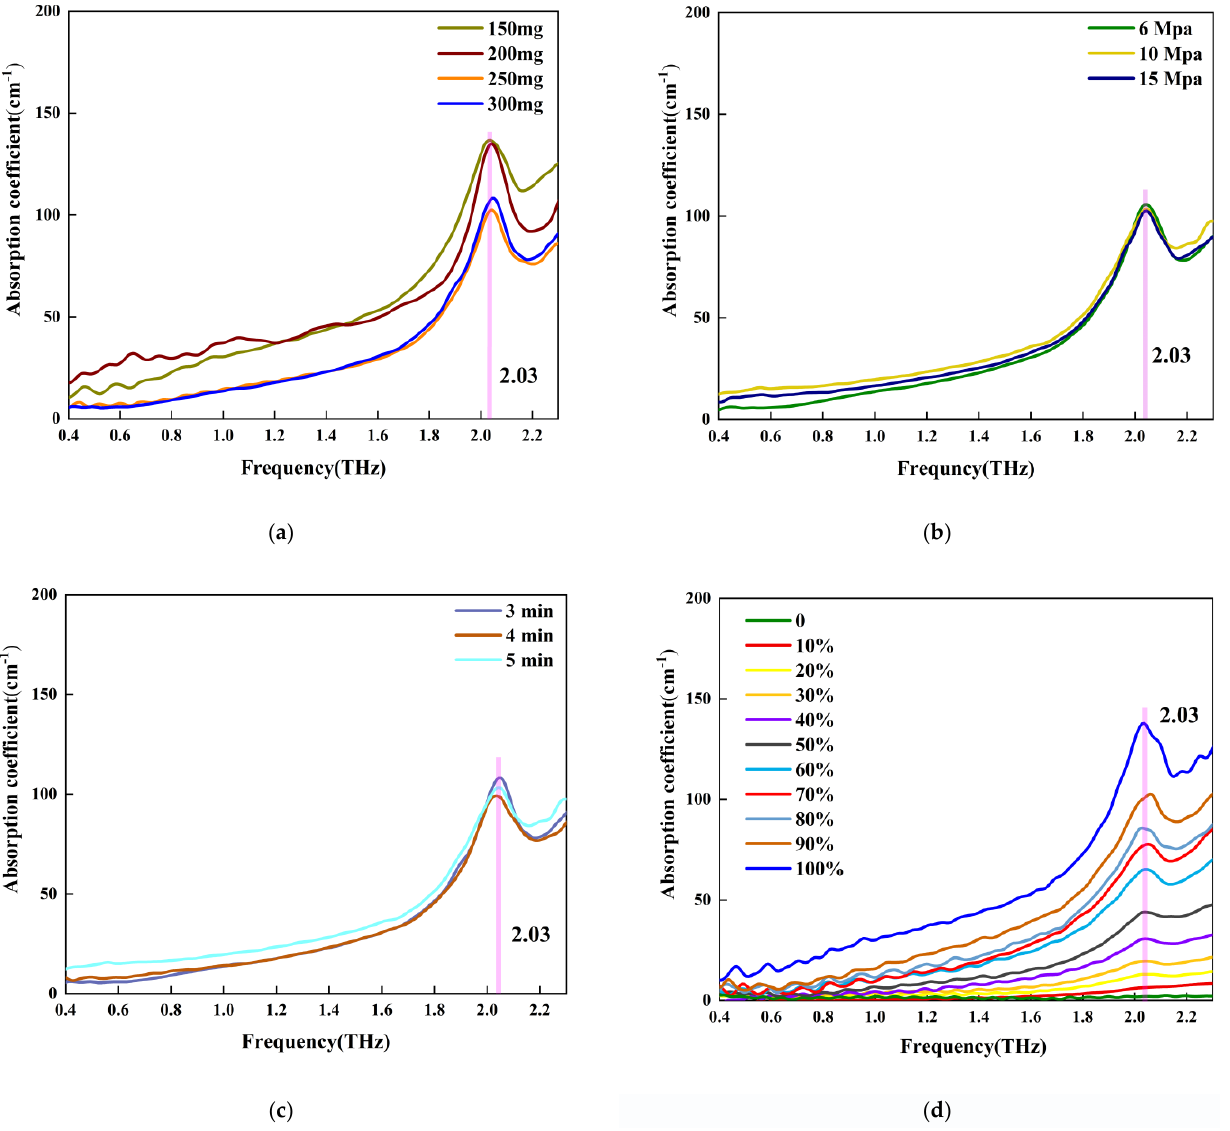
Figure 5. THz absorption spectra of four groups samples. ( a ) Absorption spectra of Group 1 samples. ( b ) Absorption spectra of Group 2 samples. ( c ) Absorption spectra of Group 3 samples. ( d ) Absorption spectra of Group 4 samples.